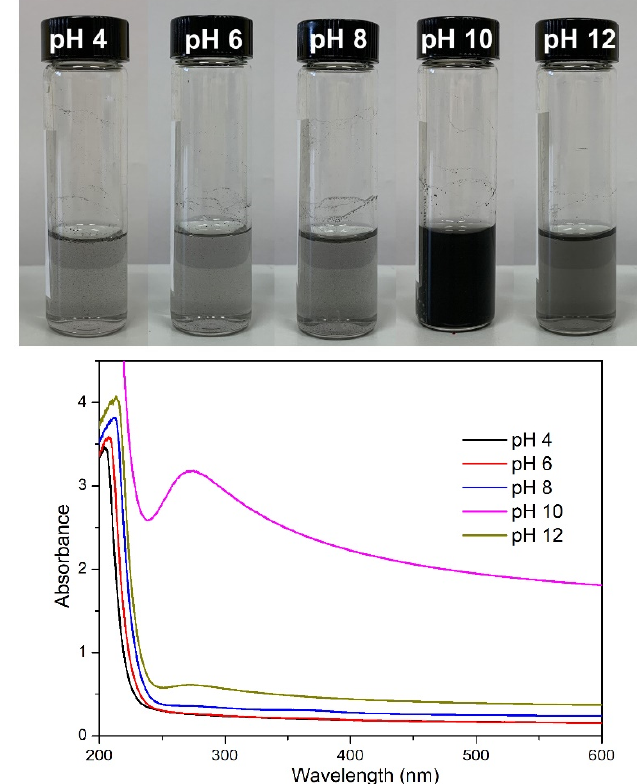
Figure 7. Photographs ( a ) and UV-vis spectra ( b ) of BPEI25/rGO with different pH